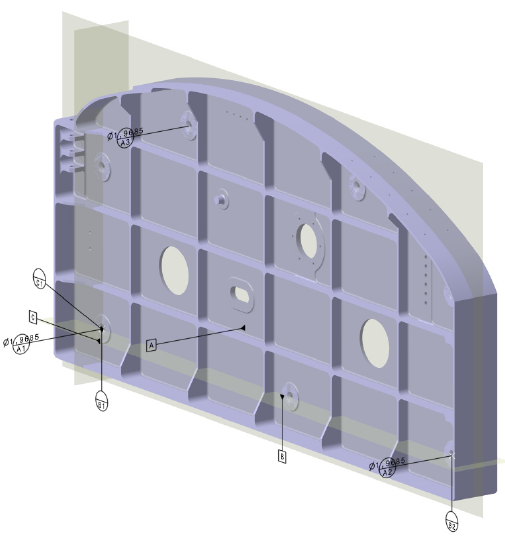
Figure 16. Main datum reference system in ASME model.